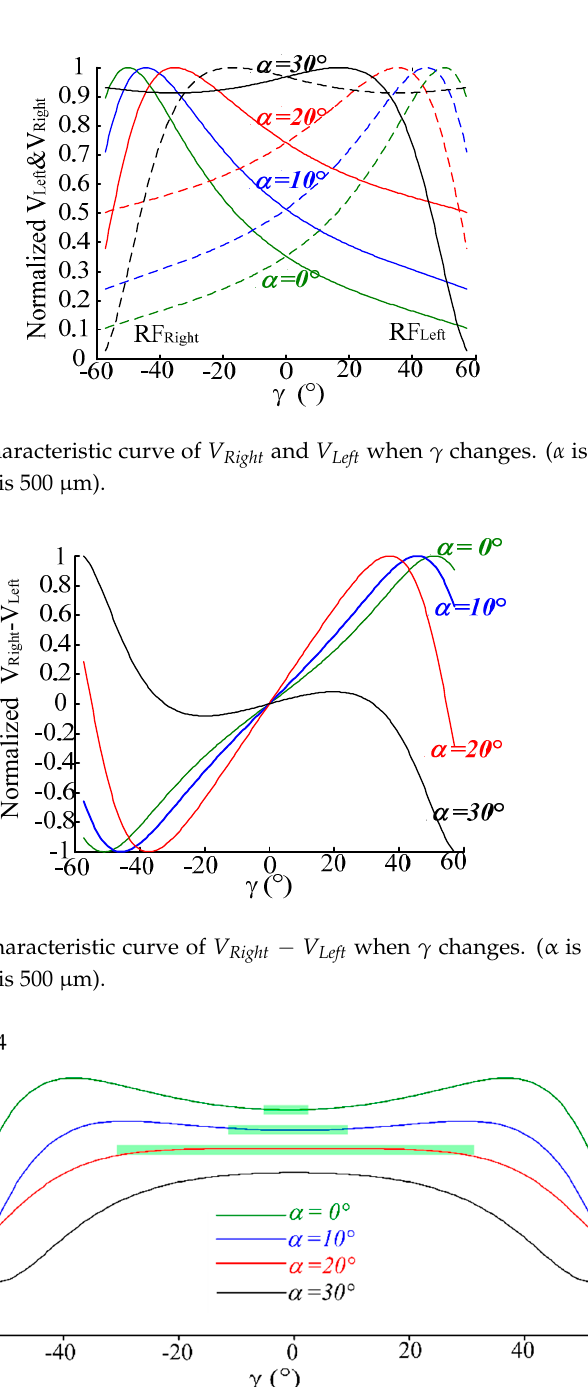
Figure 8. Derivative curve of V right − V Left . ( α is 0°, 10°, 20°, 30°, respectively, p is 0 μ m, h is 500 μ m).